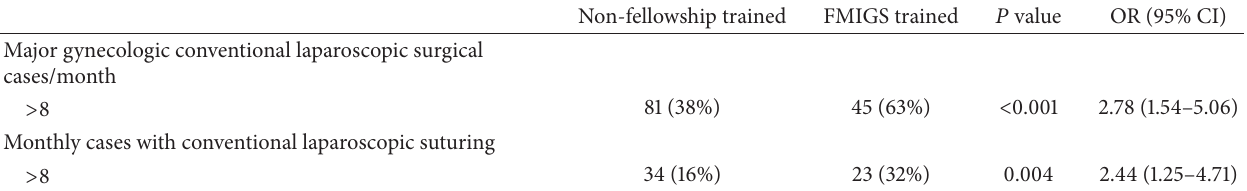
Table 3: Case volume of study participants.